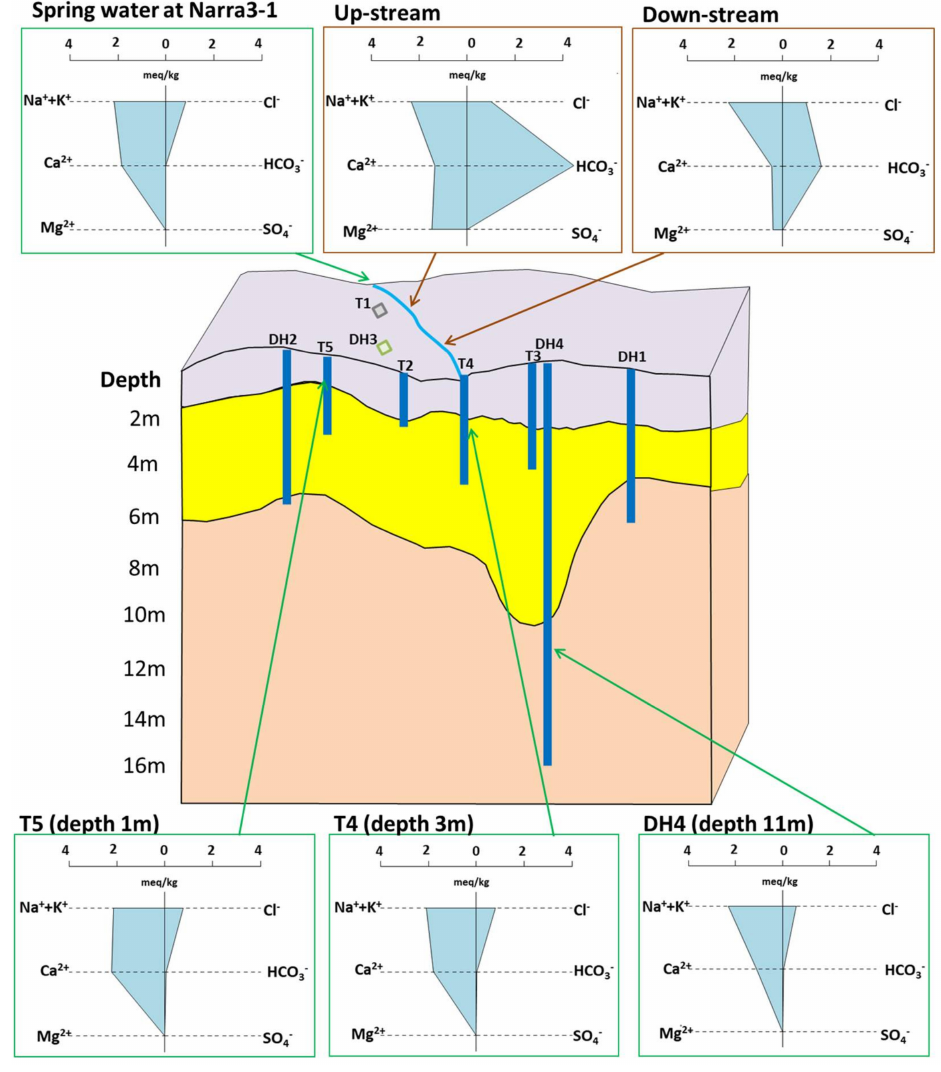
Figure 3. Stiff diagrams of water samples (spring water at Narra3-1, surface water at Narra3-2, and groundwater at Narra3-2, collected from DH2, T5, T4 and